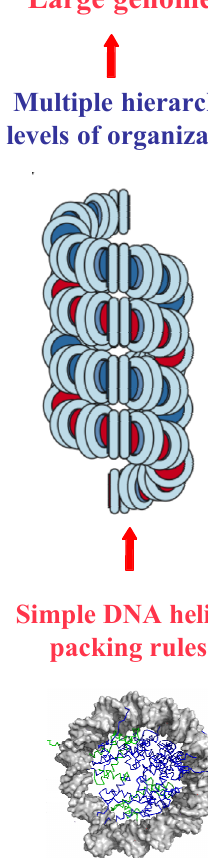
Figure 7. From chirality to genome evolution. Simple rules for DNA packaging allow multiple hierarchic levels of higher-order structure